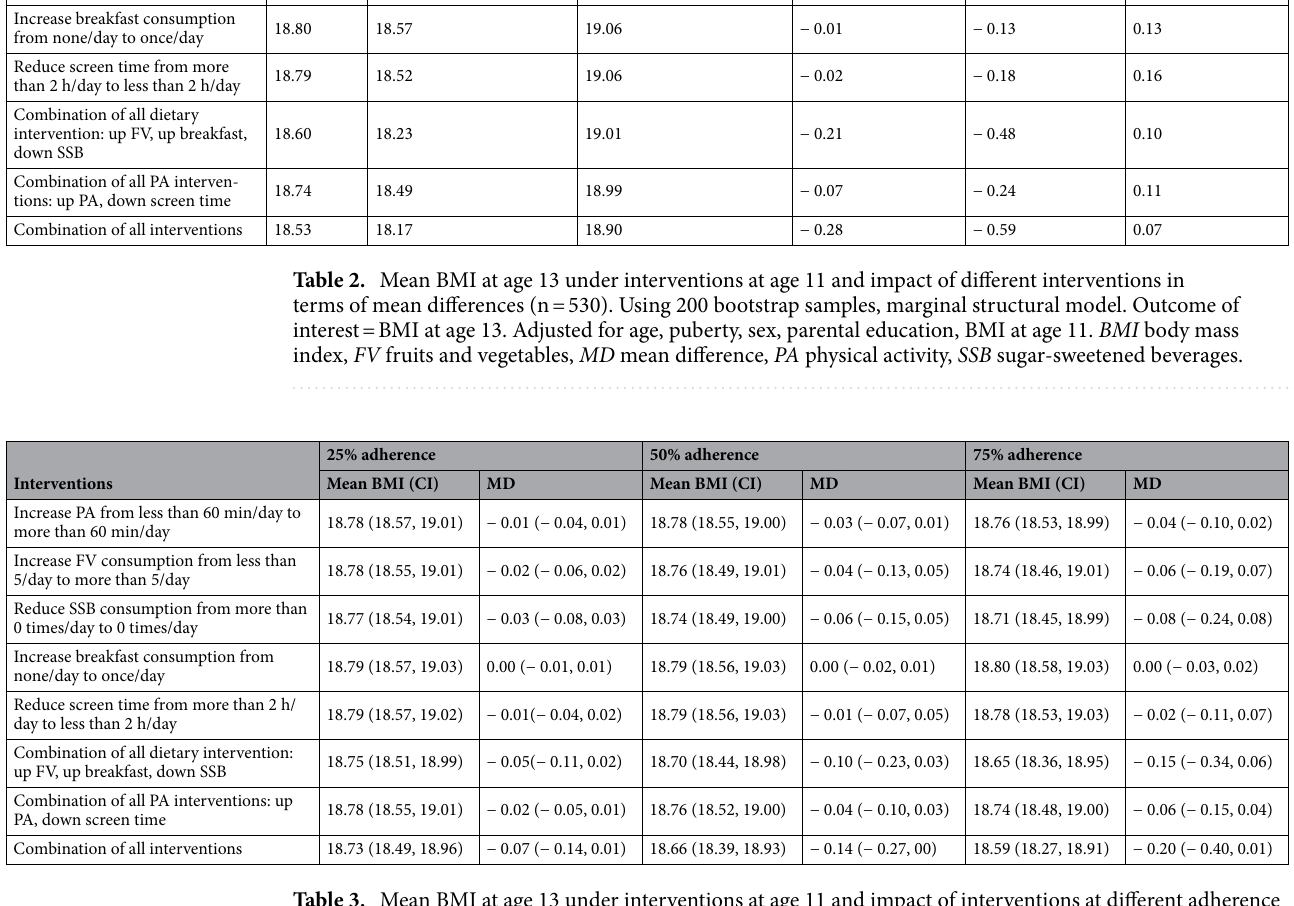
difference in BMI documented in this study after exposure to the interventions is small (even with 100% adher- ence), but can lead to clinically relevant shift in population BMI if maintained over time. Similar to these findings, meta-analyses of obesity-related interventions document rather small/modest impacts of interventions 9,10,12,13 , although the reach of and the adherence to these interventions, which is often not assessed, could also impact these results. The single behavior intervention with the highest influence on population level BMI was the one targeting the intake of sugar-sweetened beverages, which is in line with evidence from systematic reviews supporting the impact of sugar-sweetened beverages on the development of OW/OB among youth 32,33 . Increasing fruit and vegetable intake to five times or more per day by itself had a limited impact on population level BMI. A systematic review concluded that it remains unclear whether fruit and vegetable intake in isolation from lower caloric intake or increased PA will have an impact on adiposity 34 . A combination of dietary behavior interven- tions was however found to result in favorable changes in BMI, reflecting the additive impact of different dietary behaviors on body weight. PA interventions did not have a substantive effect on BMI, a finding also reported in meta-analyses of PA interventions among children 11,35 , and in a review of prospective studies 36 but in contrast to other reviews 12,13 . The study found that interventions to limit screen time to less than 2 h per day had a limited impact on the BMI of the adolescents. A systematic review of reviews suggested that cross-sectional studies reported small associations